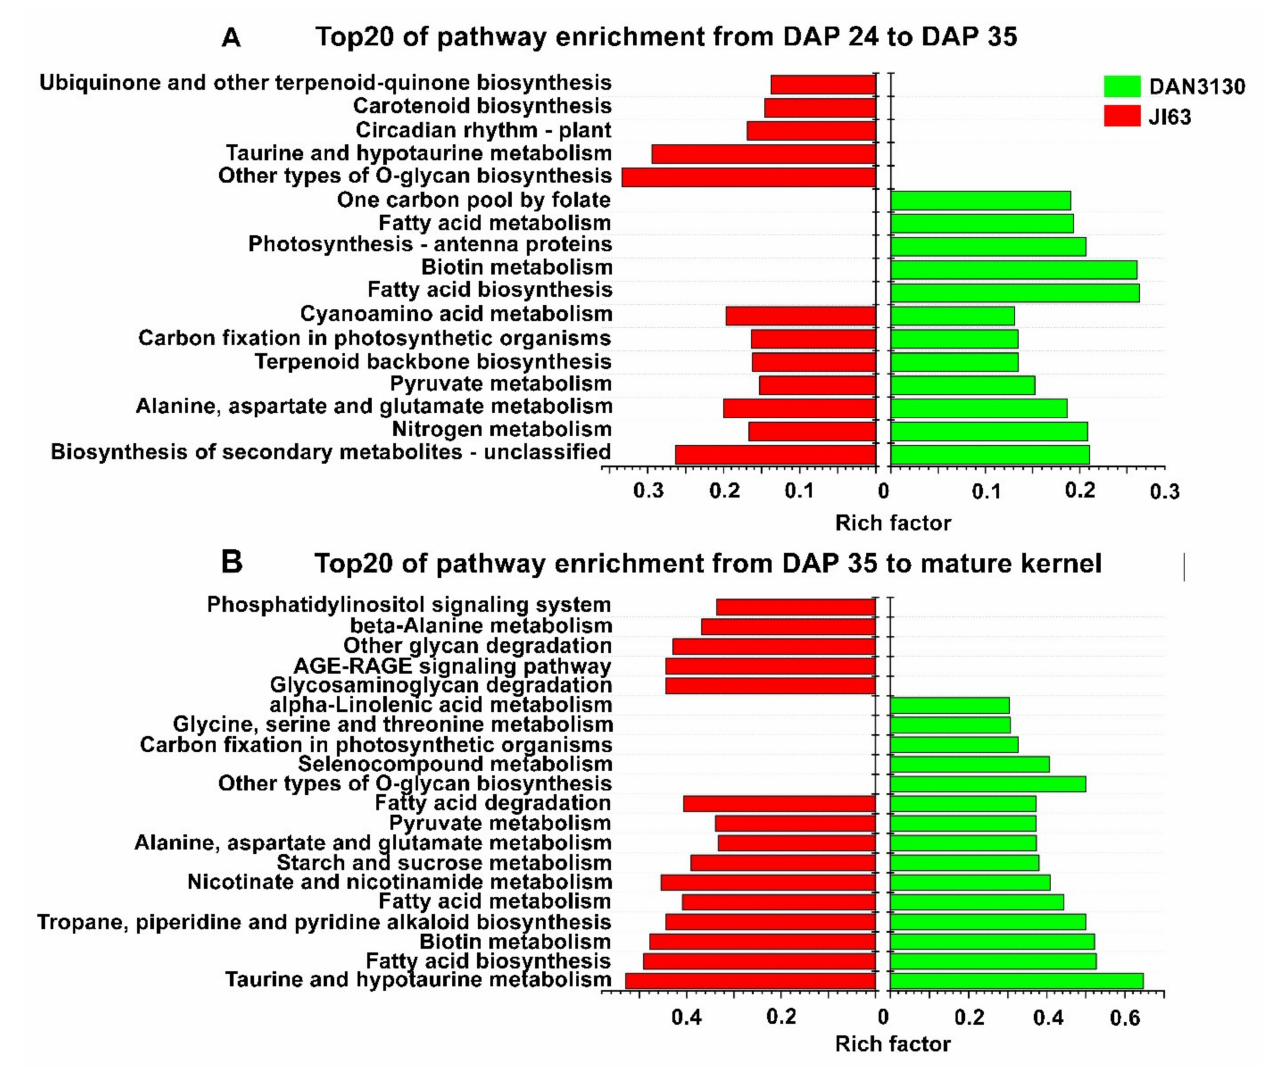
Figure 5. Bioinformatics analysis of DEGs in development-specific variation. ( A ) KEGG enrichment of DEGs during DAP 24 to DAP 35; ( B ) KEGG enrichment of DEGs during DAP 35 to mature